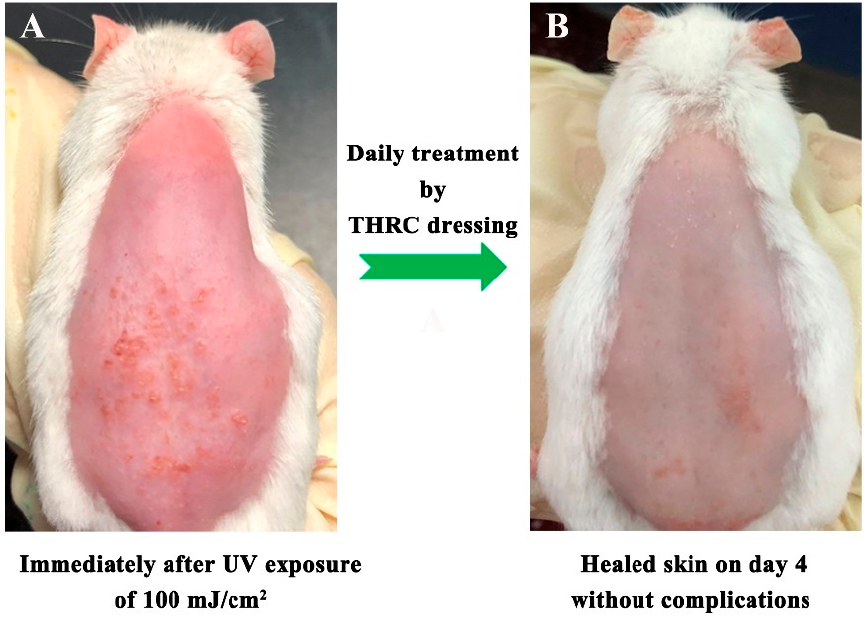
Figure 4. Photographs of the rat skin immediately after UV irradiation of 100 mJ/cm 2 with severe edema and erythema ( A ) and the healed skin after 4 days of treatment with THRC dressing without edema, erythema, and other complications ( B ).